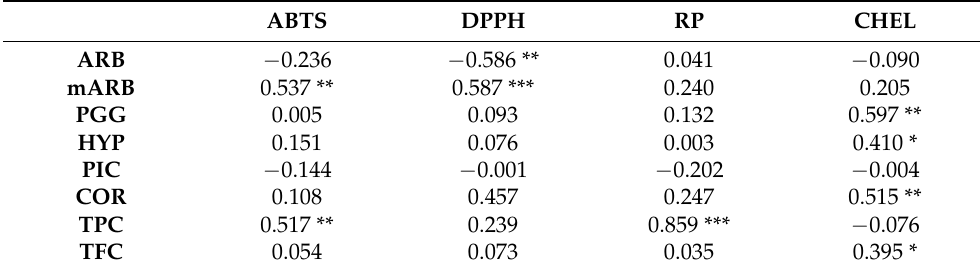
Table 4. Correlation coefficients for relationships between the studied secondary metabolites in ex- tracts of bearberry leaves from the heathlands and antioxidant parameters ( n = 30); bolded correlation coefficients are statistically significant. Explanations see Table 3.